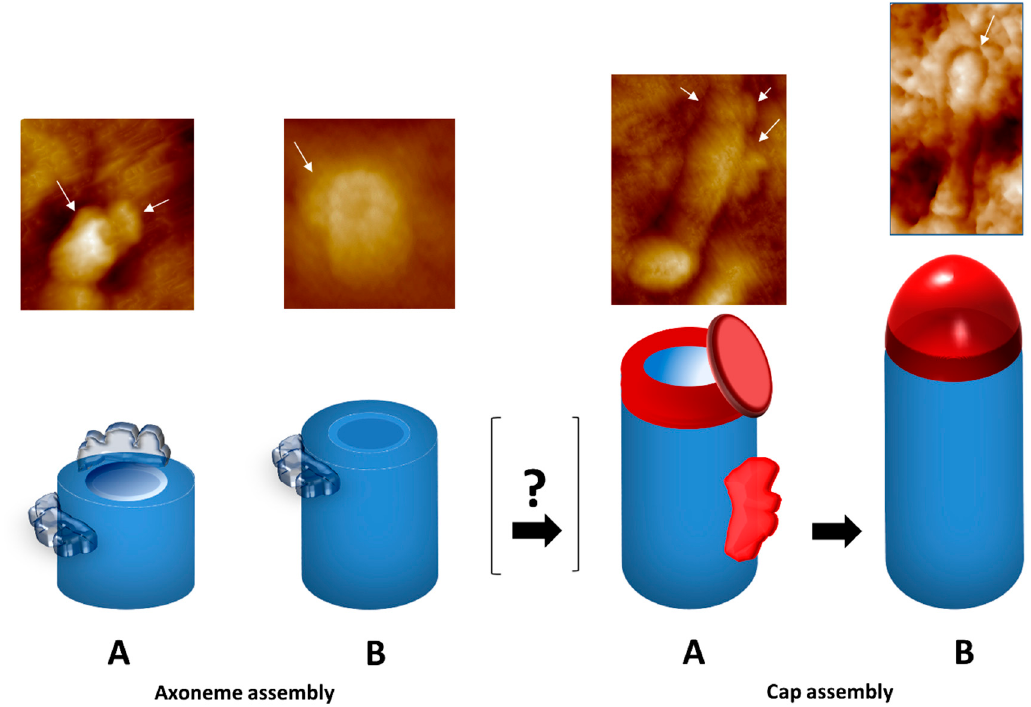
Figure 4. Several stages of Tetrahymena cilia assembly model. Axoneme assembly: (A) Three-fold structures present at the transition region and axonemes (210–460 nm) of growing Tetrahymena cilia. It was speculated that the three-fold structures function like ring sections that will progressively assemble transversally, originating a full ring (9-fold structure) contributing to the axonemal growth. Cap assembly: (A) A collar-like shape is assembled in the axonemal distal tip, shown in red, providing an incomplete cap to the cilium. The other components of the cap are larger structures that are visualized near the edge of the cilium tip (A); (B) All cap components are assembled and finally originate the full mature cap with a dome shape. In blue, the axoneme wall; in transparent dark blue the three-fold structures. The different components involved in cap assembly are shown in red. The AFM topographic images representative of the different steps of cilia and cap assembly are shown at the top of the schematic drawing. Reprinted with permission from Reference [150].